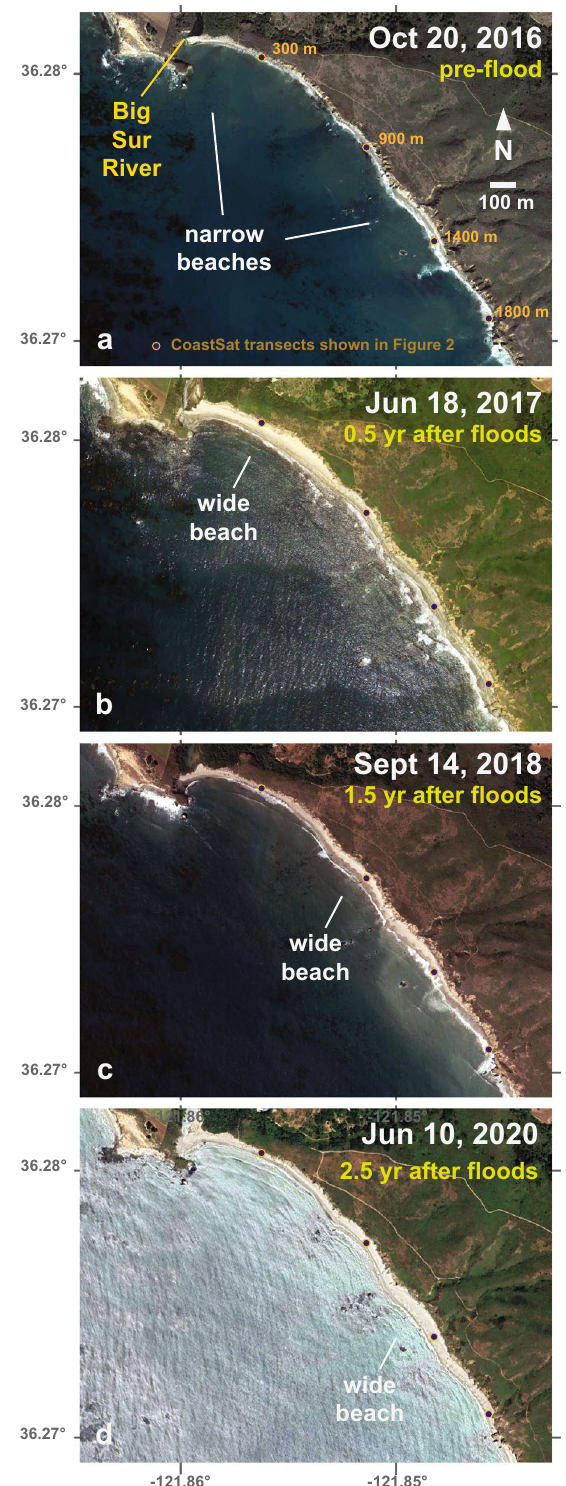
Figure 4. Imagery of the Big Sur River mouth and adjacent beaches ( a ) before and ( b – d ) after the 2016–2017 fire–flood events. The approximate location of the widest beach is highlighted by text in each image, and the location of transects presented in Fig. 2 are shown with symbols and labeled in ( a ). Maps were created from Google Earth Pro version 7.3.4.8248 imagery and data (https:// www. google. com/ earth/ versi ons/) and assembled in Abobe Illustrator version